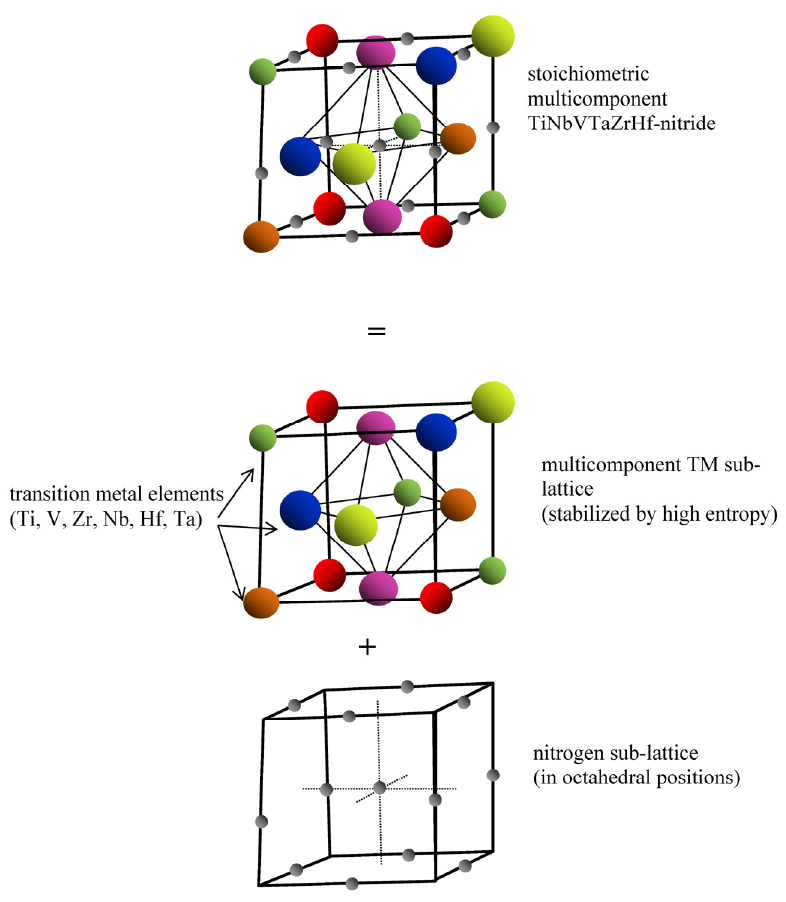
Figure 15. Schematic unit cell of stoichiometric multicomponent fcc nitride with nitrogen in octahedral interstitial locations described as a superposition of fcc TM and nitrogen sub-lattices.